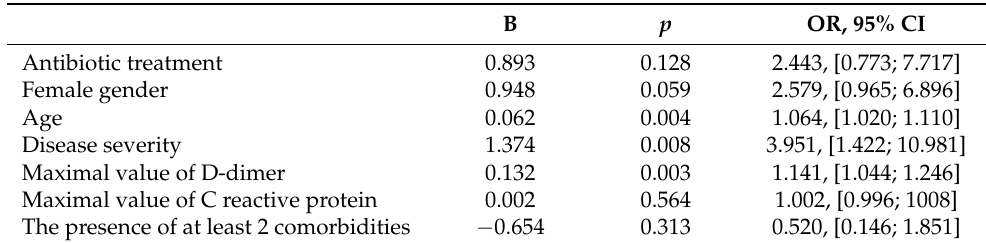
Table 4. The association between antibiotic therapy and mortality—logistic regression model after the adjustment for other involved prognostic factors.